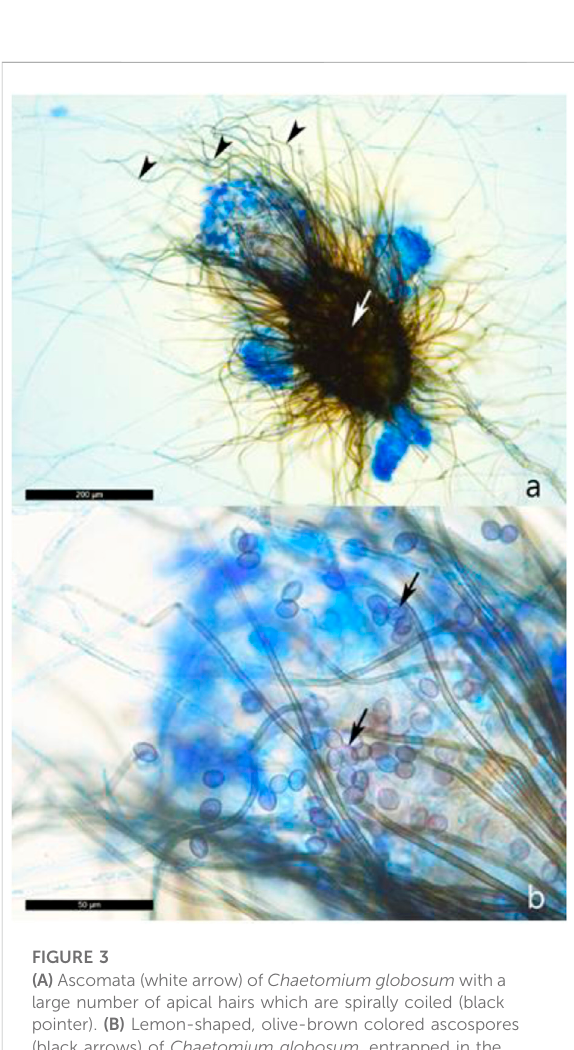
FIGURE 3 (A) Ascomata (white arrow) of Chaetomium globosum with a large number of apical hairs which are spirally coiled (black pointer). (B) Lemon-shaped, olive-brown colored ascospores (black arrows) of Chaetomium globosum , entrapped in the apical